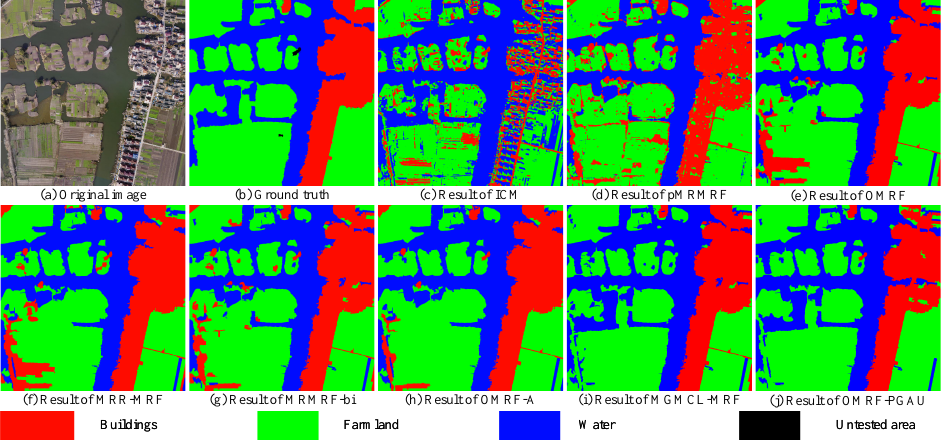
Figure 15. Semantic segmentation results for small size areail